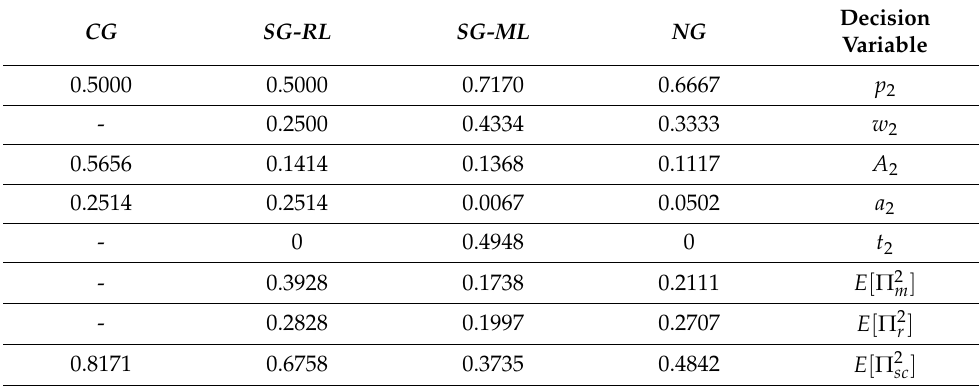
Table 6. The results for the numerical example 2 in the second